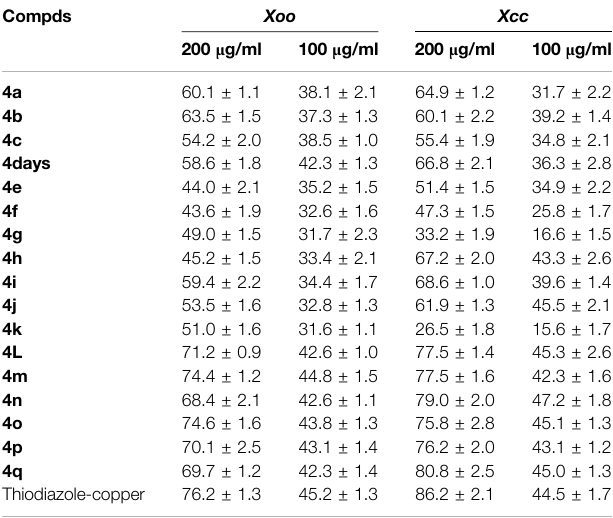
TABLE 3 | The in vitro antibacterial activities of the target compounds 4a – 4q .